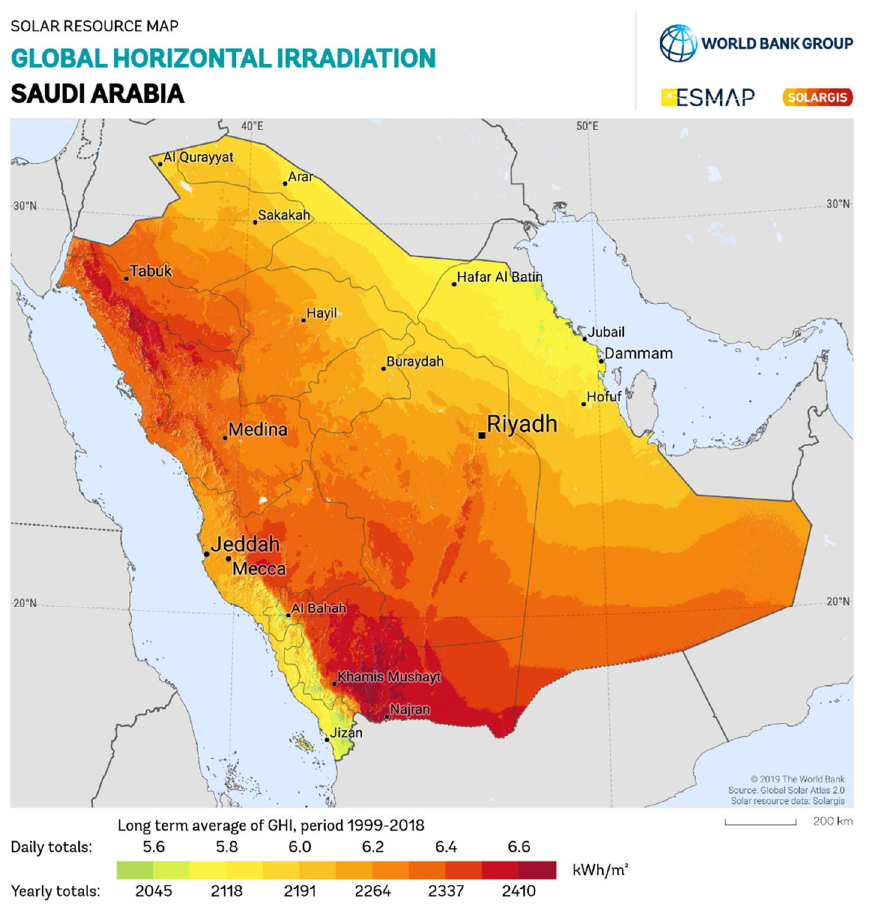
Figure 5. The annual average of global horizontal irradiance. Reprinted from Solar resource maps of Saudi Arabia, The World Bank, Source: Global Solar Atlas 2.0, Solar resource data: Solargis, Copyright (2022), (CC BY 4.0)[49].